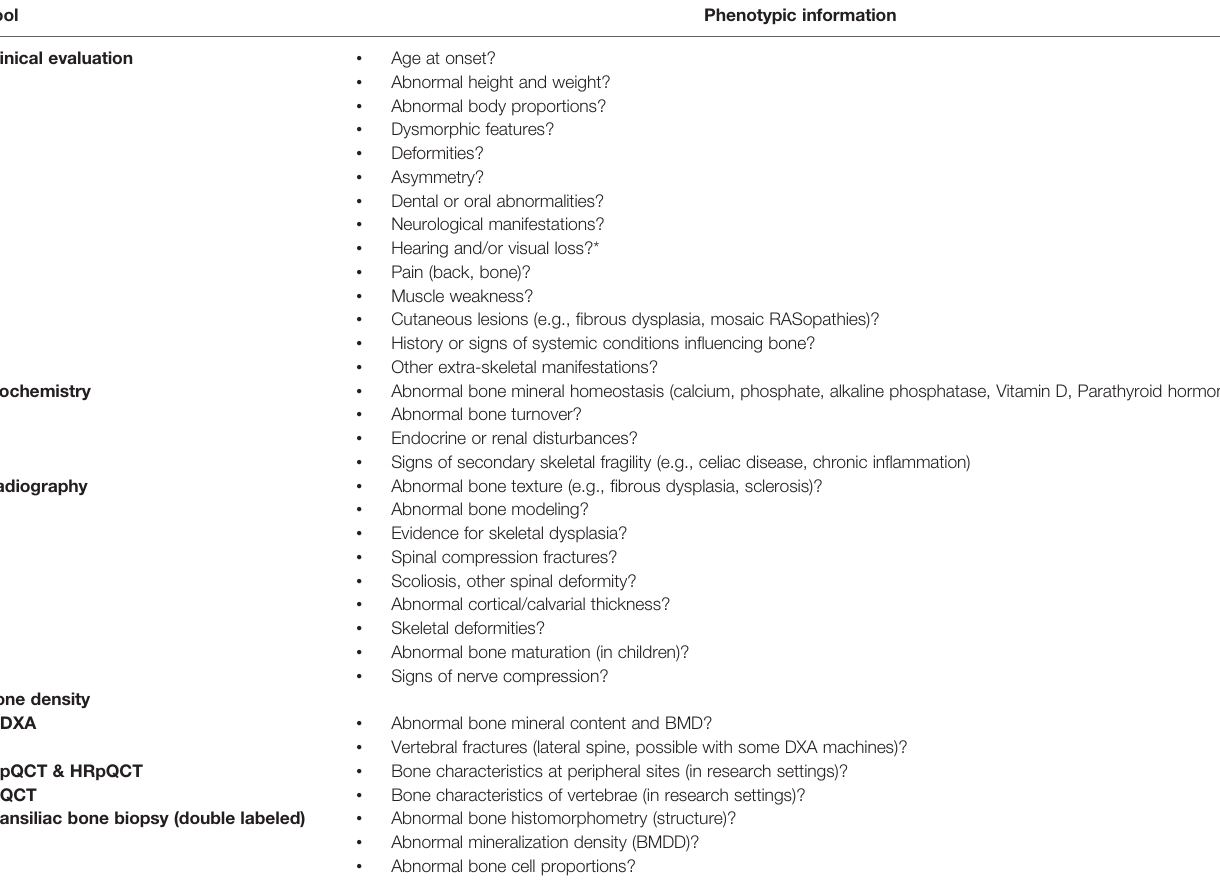
TABLE 2 | Tools and relevant clinical outcomes to be considered for careful skeletal phenotyping in patients with a skeletal phenotype.